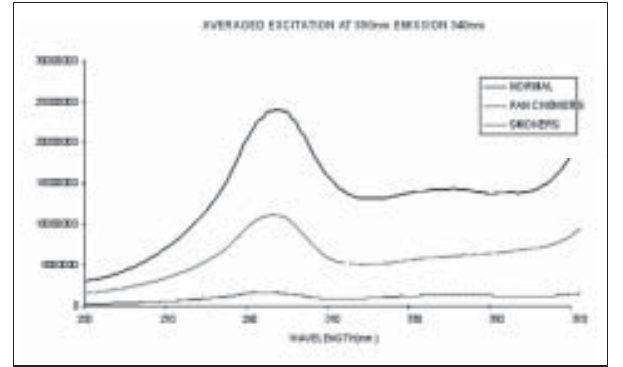
Fig. 4- Averaged fluorescence excitation spectra of normal,